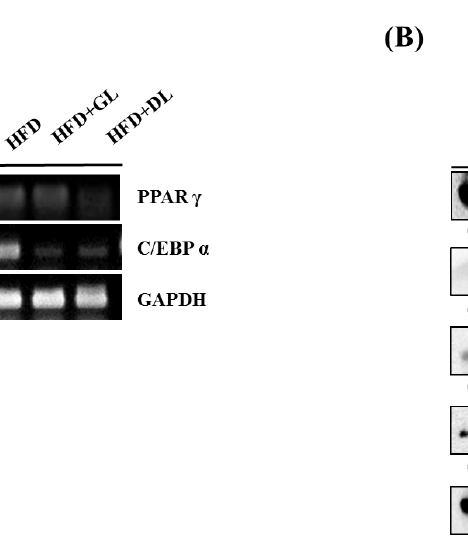
Figure 3. Effects of GL and DL on the mRNA and protein expression of adipogenic genes in adipose tissues. Rats were fed an ND or HFD. Additionally, HFD-fed rats were treated with GL or DL at a dose of 3.3 mg/kg/day. Epididymal WAT was acquired on the final day of the experiments. ( A ) mRNA expression of PPAR γ , C/EBP α , and GAPDH in epididymal WAT; ( B ) Protein expression of the indicated adipogenic genes in epididymal WAT. Photographs are representative pictures from three independent experiments.